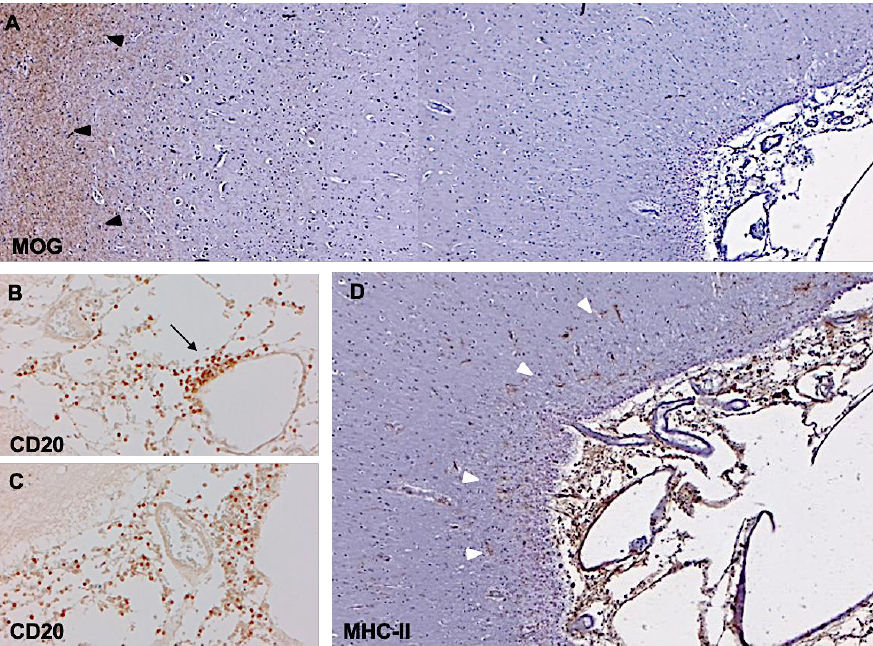
Figure 2. Demyelinating cortical lesion and meningeal inflammation in chronic progressive MS. Immunohistochemistry for myelin oligodendrocyte protein (MOG) shows extensive subpial demyelination involving the neocortical grey matter, contiguous to MOG-positive brain tissue ( A , black arrowheads). The lesion is in close proximity to inflamed meninges containing an elevated number of CD20+ B cells, either accumulated ( B , arrow) or diffused ( C ), around subarachnoid vessels. Substantial increased density of MHC-class II+ activated microglia can be observed in the most external cortical layers (white arrowheads) at the pia/CSF boundary ( D ) nearby inflamed meninges. Original magnifications: 50× ( A ), 100× ( D ), 200× ( B , C ).